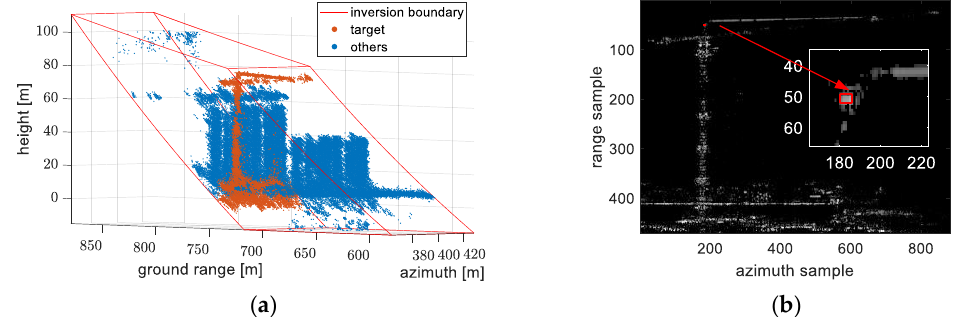
Figure 22. The tower crane extracted from the selected region in experiment 1: ( a ) 3-D point cloud containing the tower crane and buildings; ( b ) 2-D SAR image corresponding to the tower crane. The red frame in (b) is used for the quantitative analysis of the reconstructions under different models. Compared to experiments using simulated data, we do not have ground truth for targets on the ground in experiments using measured data. For this reason, the MAE and RMSE of the positions of estimated scatterers could not be calculated. Firstly, we compare reconstruction results of different models visually. Then, we choose estimated scatterers from the same area in 2-D SAR images under different models to do the quantitative anal- ysis. In Figure 23a,b, the reconstructed tower crane under model 5 (the exact form of the spherical wavefront model) and model 6 (the approximate form of the spherical wave- front model) are similar; the reconstructed tower crane under model 1 (the exact form of